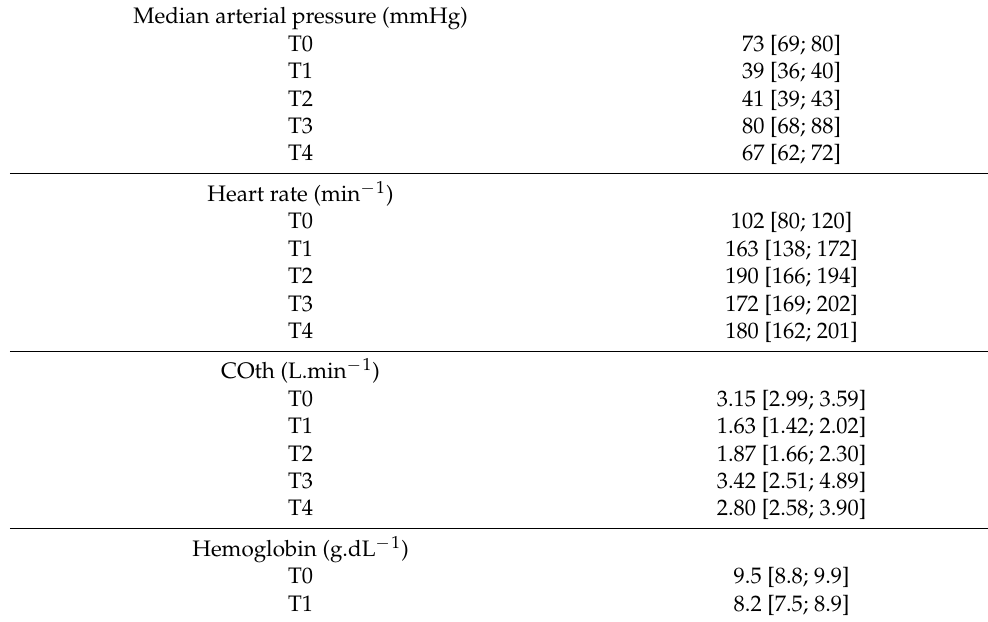
Table 1. Hemodynamic and biological data at baseline (T0), hemorrhagic phase (T1), maintenance phase (T2), resuscitation phase (T3), and stabilization phase